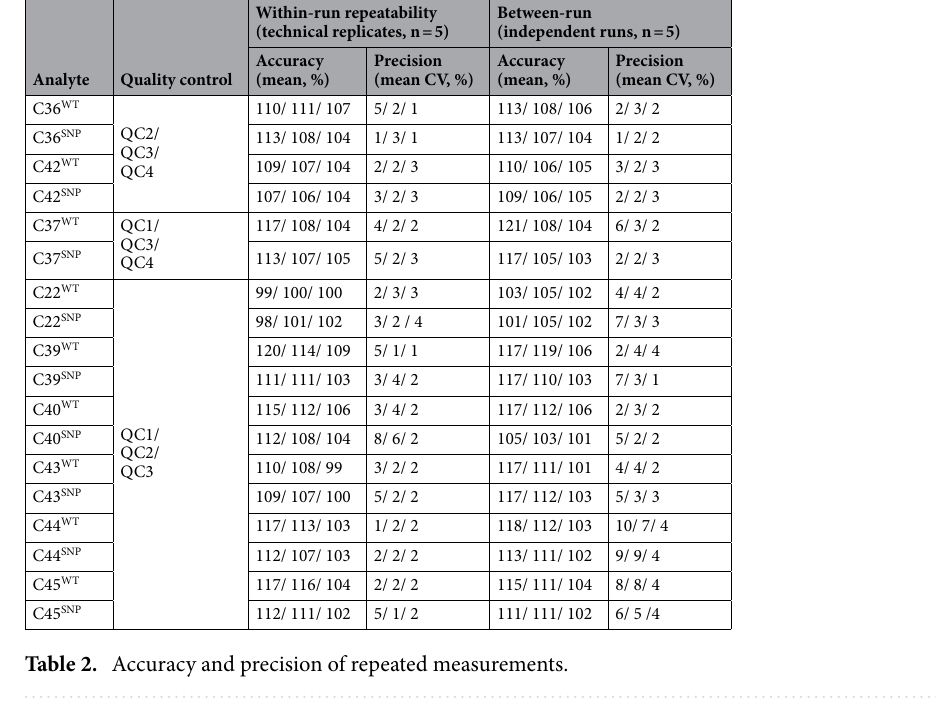
Within-run repeatability (technical replicates, n =